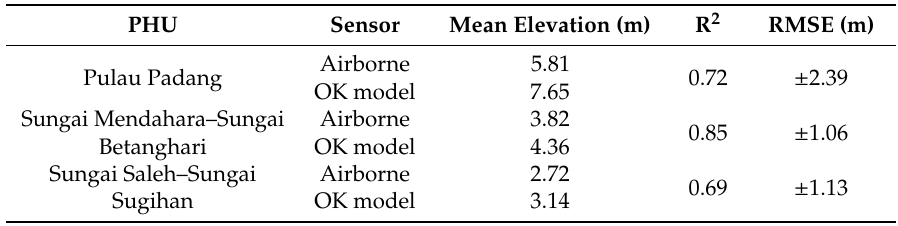
Table 3. Comparison of the elevation based on airborne data and ordinary kriging (OK) results for the di ff erent PHUs located on Sumatra (N points = 500 per